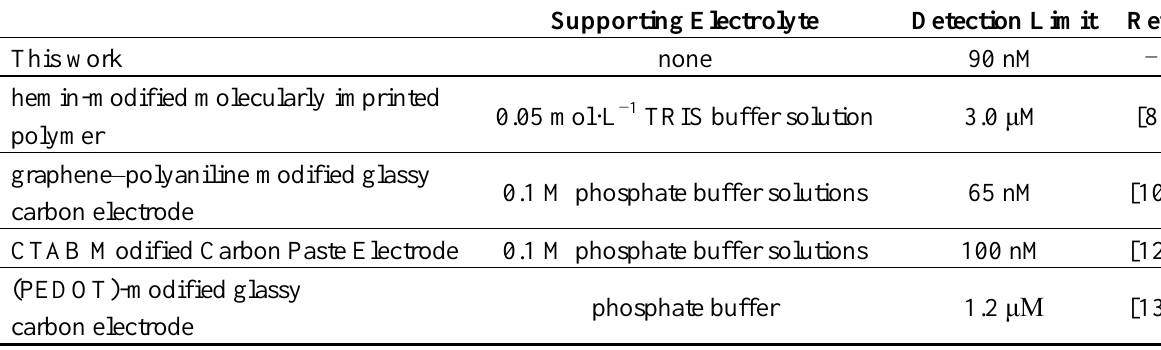
Table 1. Detection limit of our sensor compared to that of other electrochemical sensors. Supporting Electrolyte